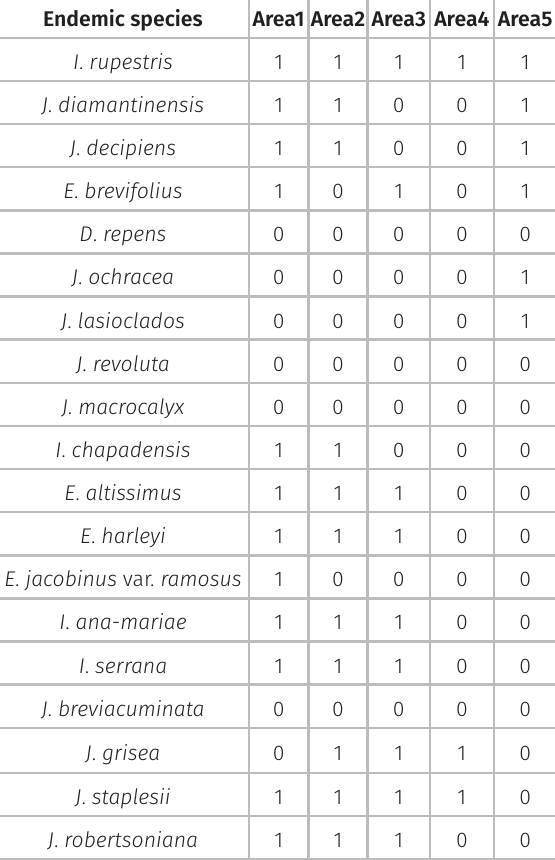
Table I. Presence and absence matrix of Convolvulaceae species from the Espinhaço Range. Endemic